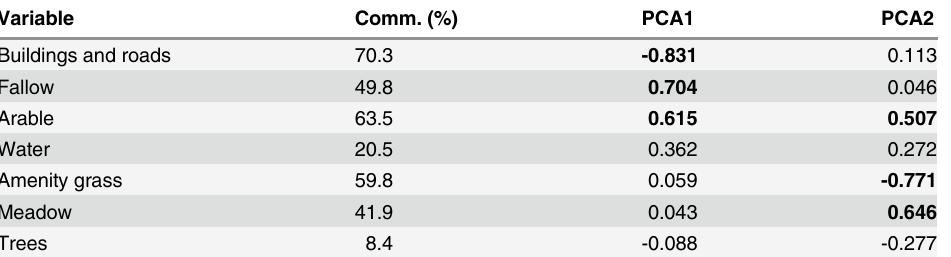
Trees 8.4 -0.277 After varimax raw rotation, highly signi fi cant loading factors of the variables on the PCA axes are emboldened. Comm. (%) is the percentage of the total communality of each variable extracted by the fi rst two PCA